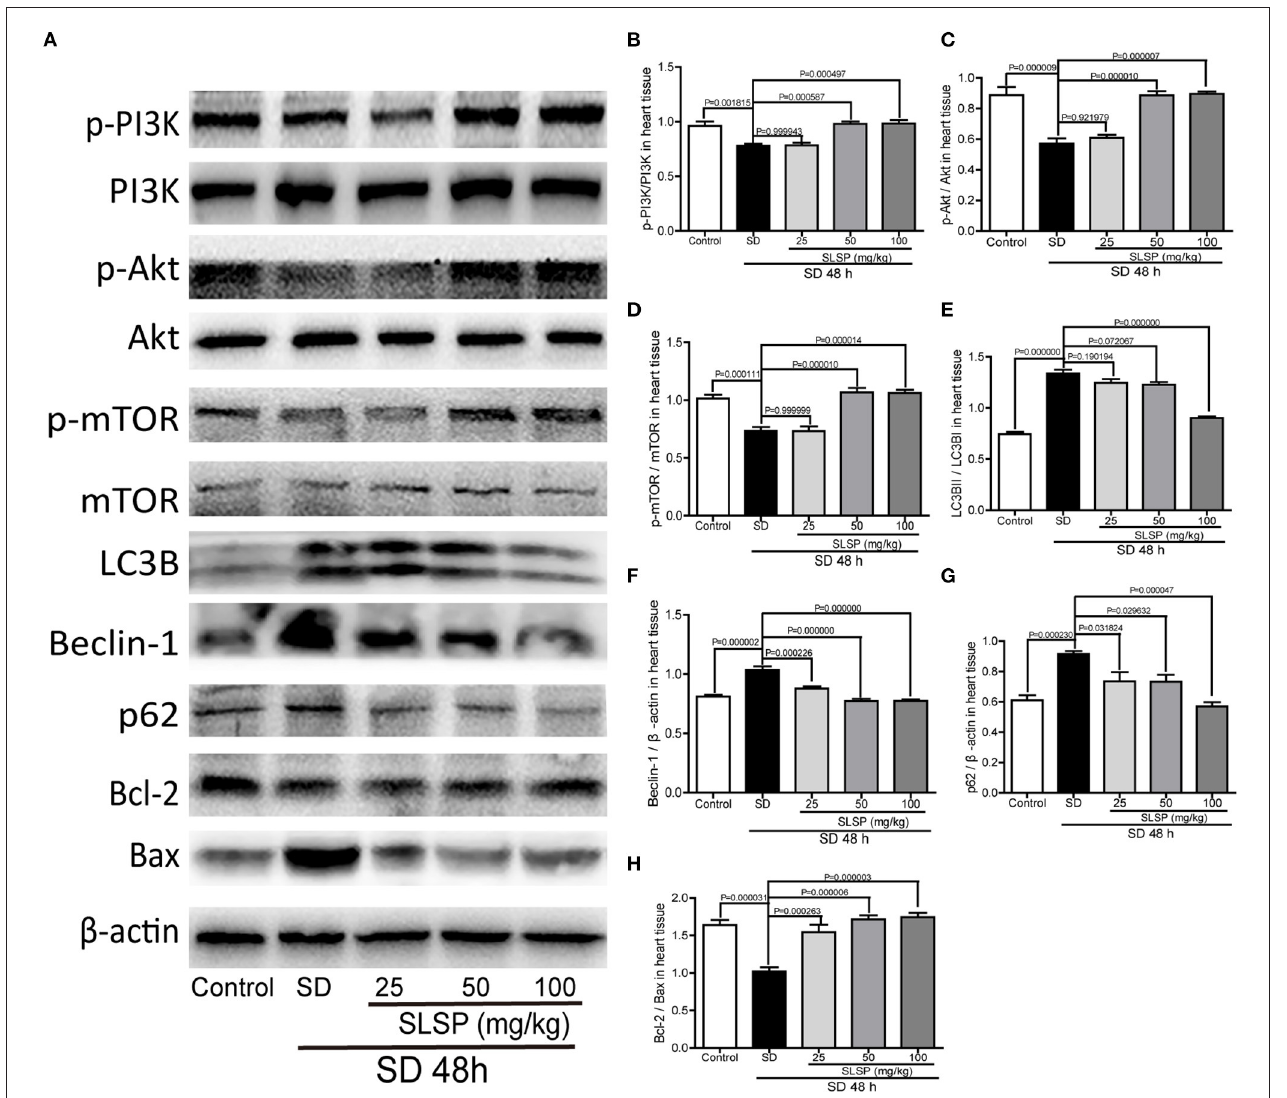
FIGURE 4 | SLSP inhibited the expressions of proteins related to autophagy and apoptosis in heart tissue of SD mice. (A) Western blotting bands of respective proteins in heart tissue of mice. (B–H) Gray intensity analysis. N = 5/group.